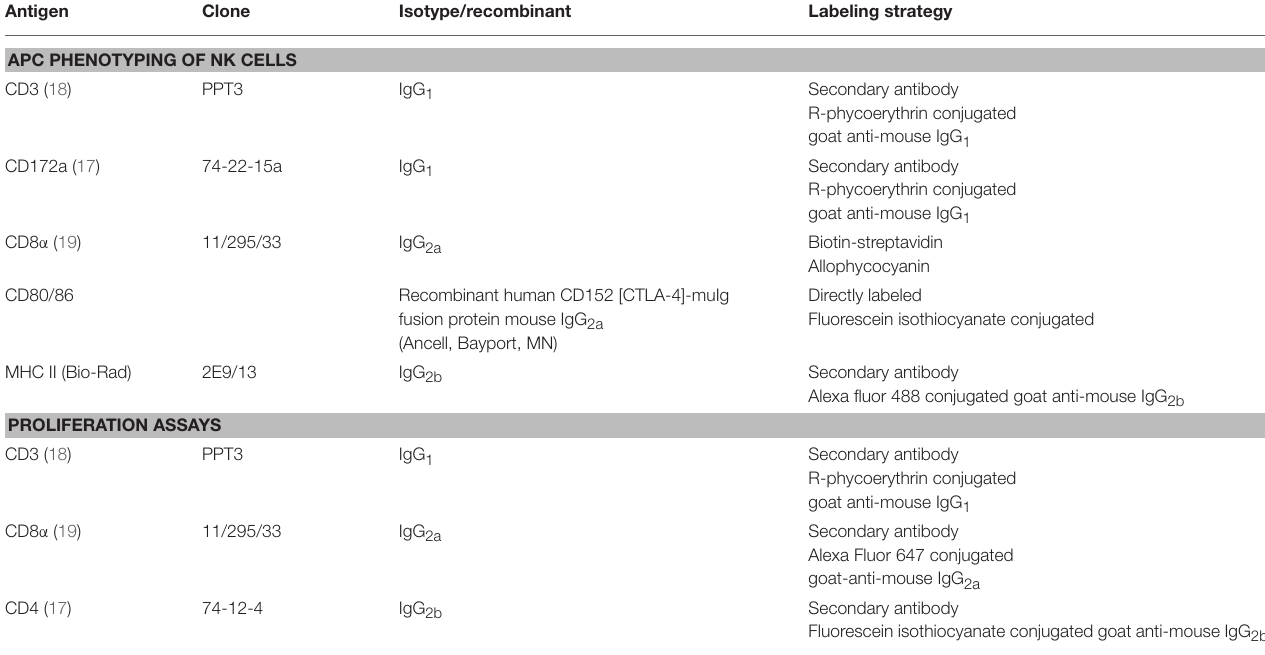
TABLE 1 | Primary and secondary antibodies used for cell surface expression analysis by flow cytometry. Antigen